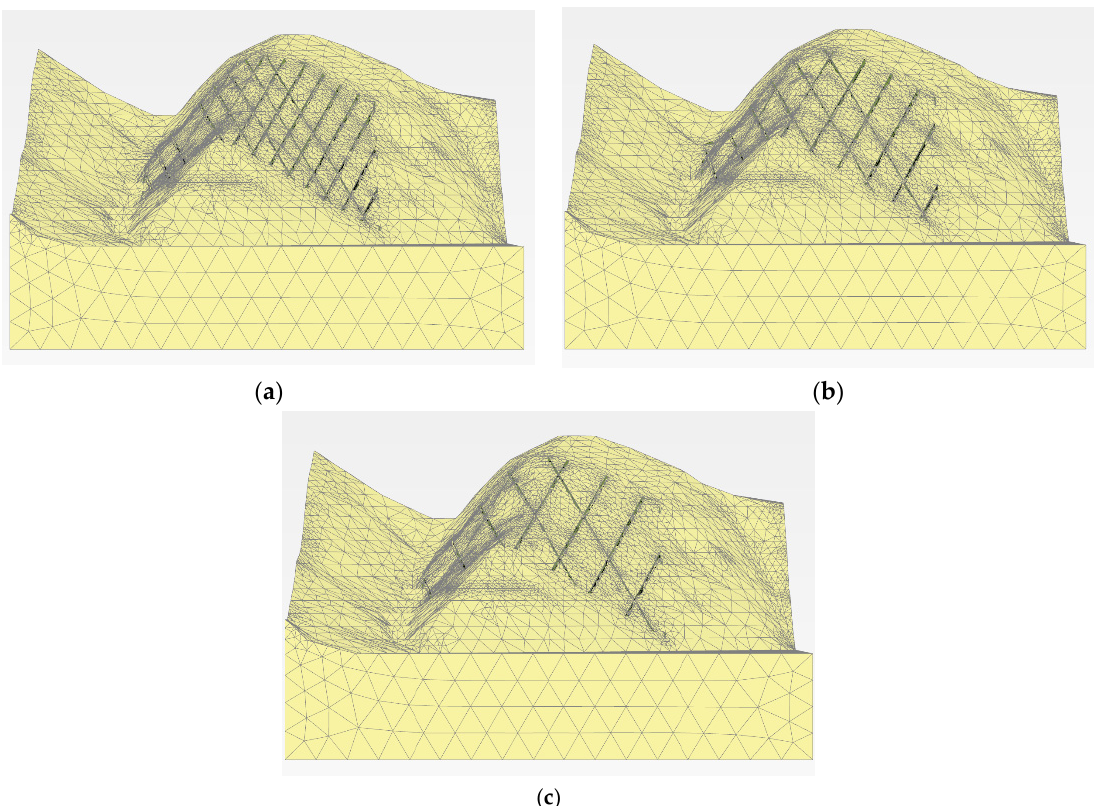
Figure 11. The 3D view of an FE mesh based on joint spacing: ( a ) 10 m, ( b ) 15 m, and ( c ) 20 m.